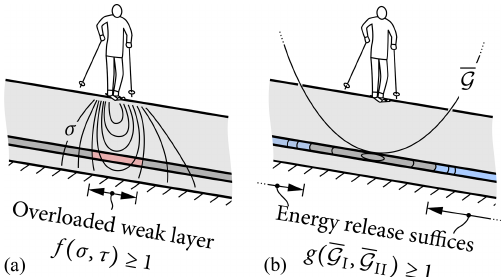
Figure 2. Coupled stress and energy criterion for the case of a skier- loaded snowpack. On the left the condition of a locally overloaded weak layer and on the right the second condition of sufficient en- ergy release rate are shown. The stress condition has the effect of an upper bound on possible nucleated cracks, whereas the energy con- dition provides a lower bound on the crack lengths as short cracks do not release sufficient